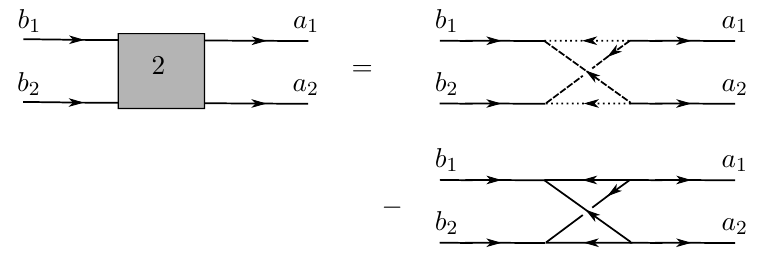
Figure 9 . The two-loop e(cid:11)ective vertex that can contribute to the amplitude A ~n in the N = 2 superconformal theory. The (cid:12)rst diagram on the right hand side is the Q -contribution involving the fundamental hypermultiplets, while the second diagram is the H -contribution due to the adjoint hypermultiplet and thus comes with a minus